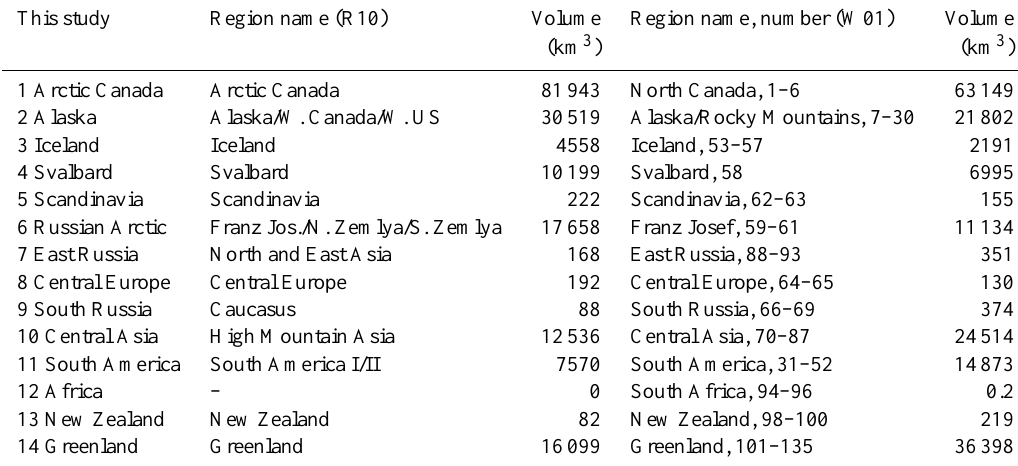
Table 1. Regions and initial volume in 1990 (km 3 ) used in this